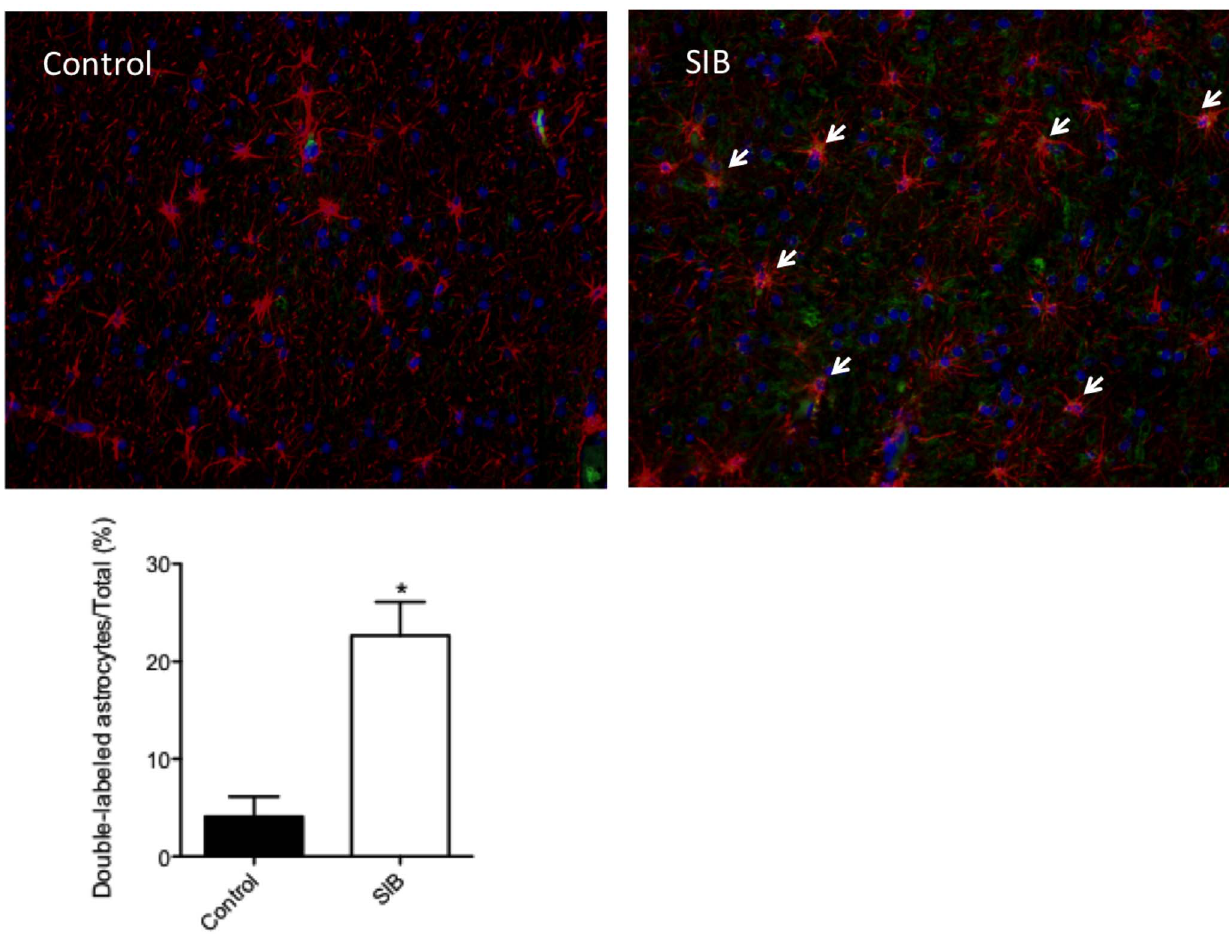
Figure 5. Immune activation of astrocytes in macaques with SIB. Control macaques have low levels of TLR2 expression in brain, including on astrocytes (a). In macaques with SIB (b), this level increases dramatically (from about 4% to 22%) indicating immune activation (c). TLR2 is represented in green, GFAP expression in red.